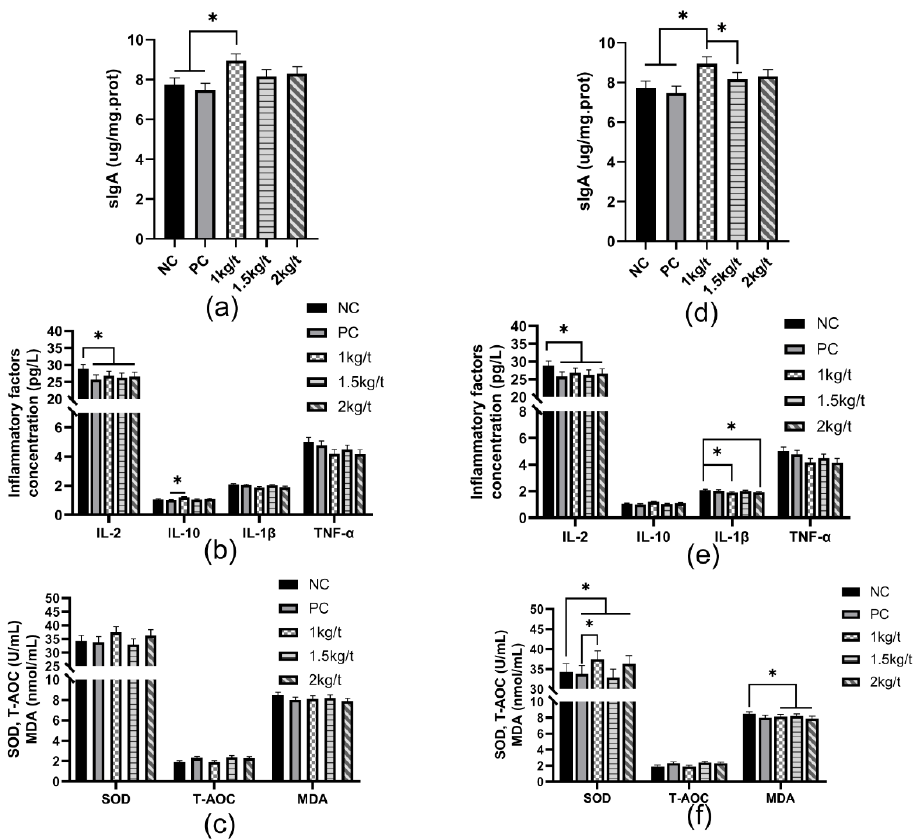
Figure 3. Effects of joint application of Lactobacillus plantarum and Bacillus subtilis on intestinal antioxidant capacity and immune function in weaned piglets. ( a ) Jejunum concentrations of sIgA in weaned piglets. ( b ) Jejunum concentrations of inflammatory factors in weaned piglets. ( c ) Jejunum concentrations of antioxidant-related substances in weaned piglets. ( d – f ) are the concentration of sIgA, inflammatory factors, and antioxidant-related substances in weaned piglets’ colons. “*” means there were statically significant differences ( p < 0.05). NC, a control diet; PC, NC + 150 ppm mucilage sulfate.